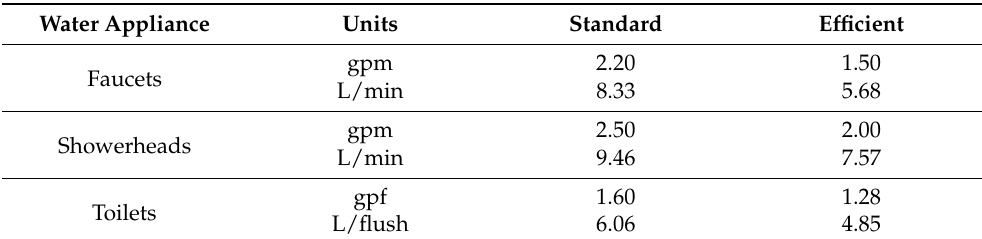
Table 3. Technical specifications for standard and efficient water use